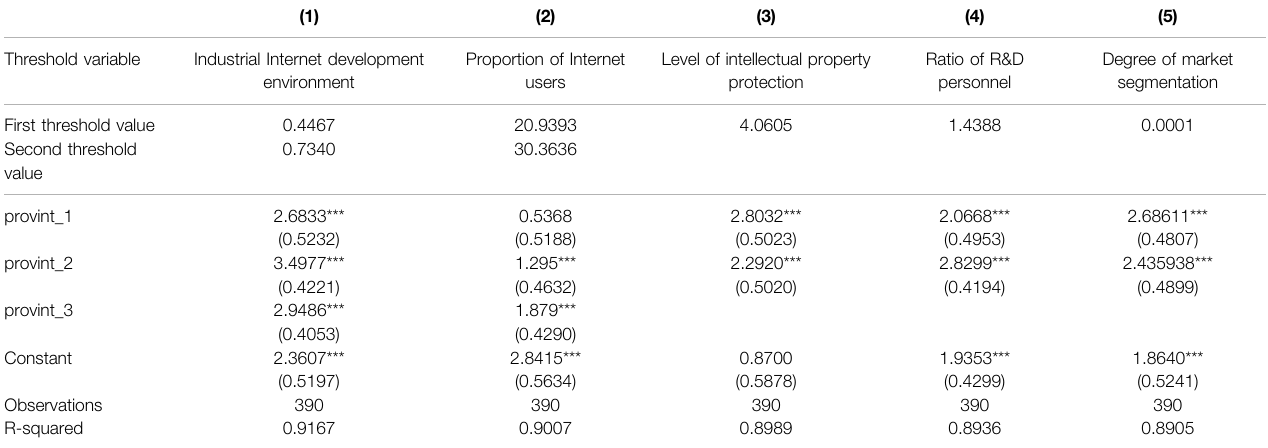
TABLE 7 | Regression results of threshold models.